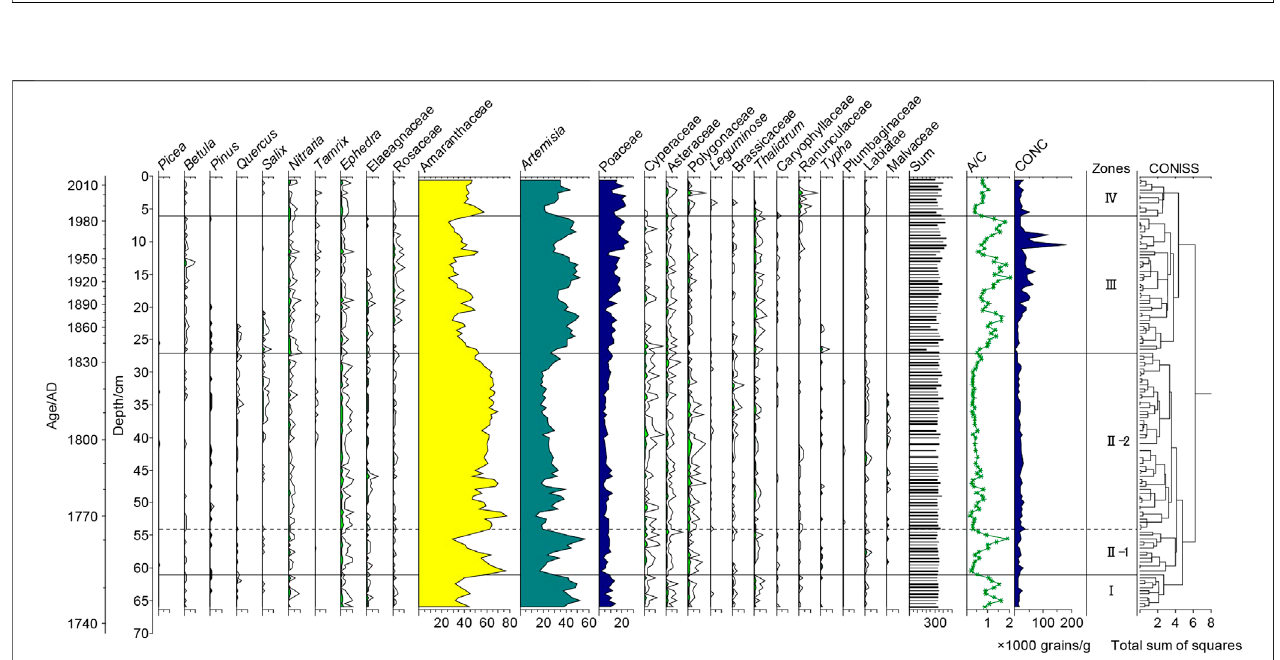
FIGURE 3 | Pollen percentage diagram (%) for core TE18A spanning the last 300 years (open curves are a 5 × exaggeration of scale).